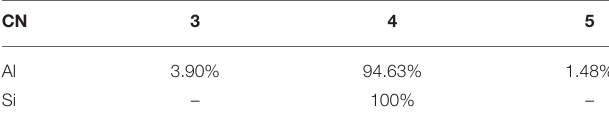
TABLE 2 | Coordination number (CN) of Al and Si in the N-A-S-H